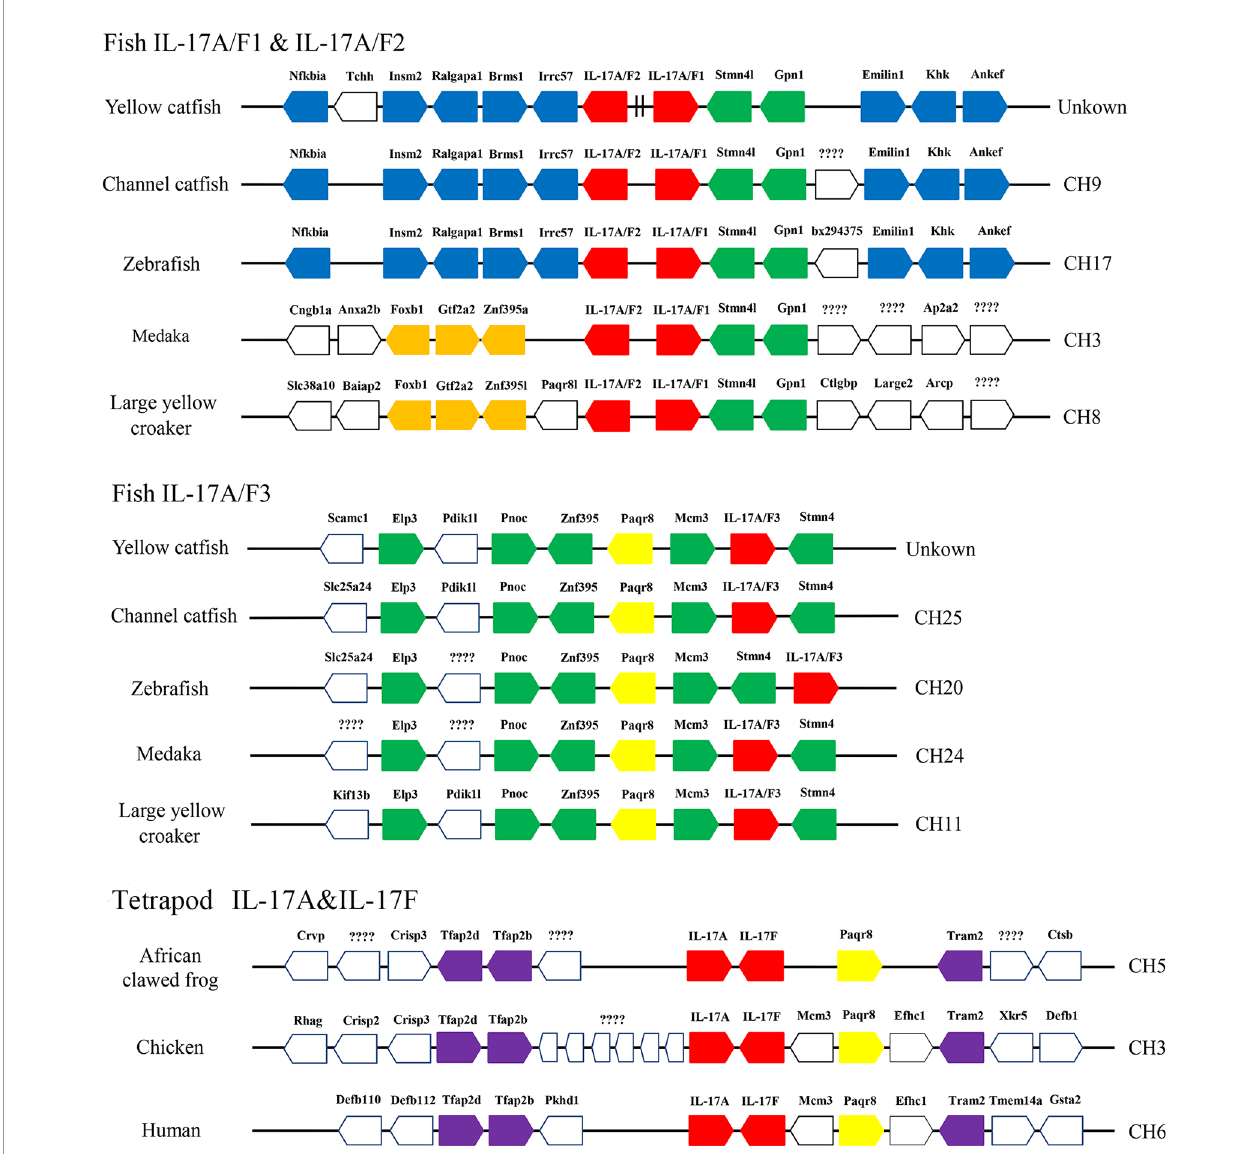
FIGURE 3 | Schematic representation of gene synteny at the IL-17A/Fs loci in teleosts and the IL-17A and IL-17F loci in African clawed frog, chicken and human. The IL-17A/Fs, IL-17A and IL-17F genes are shown in red, the other syntenic genes are shown to be conserved across vertebrates (yellow), only across teleosts (green), only in yellow cat fi sh, channel cat fi sh and zebra fi sh (blue), only in medaka and large yellow croaker (orange), and only across tetrapod